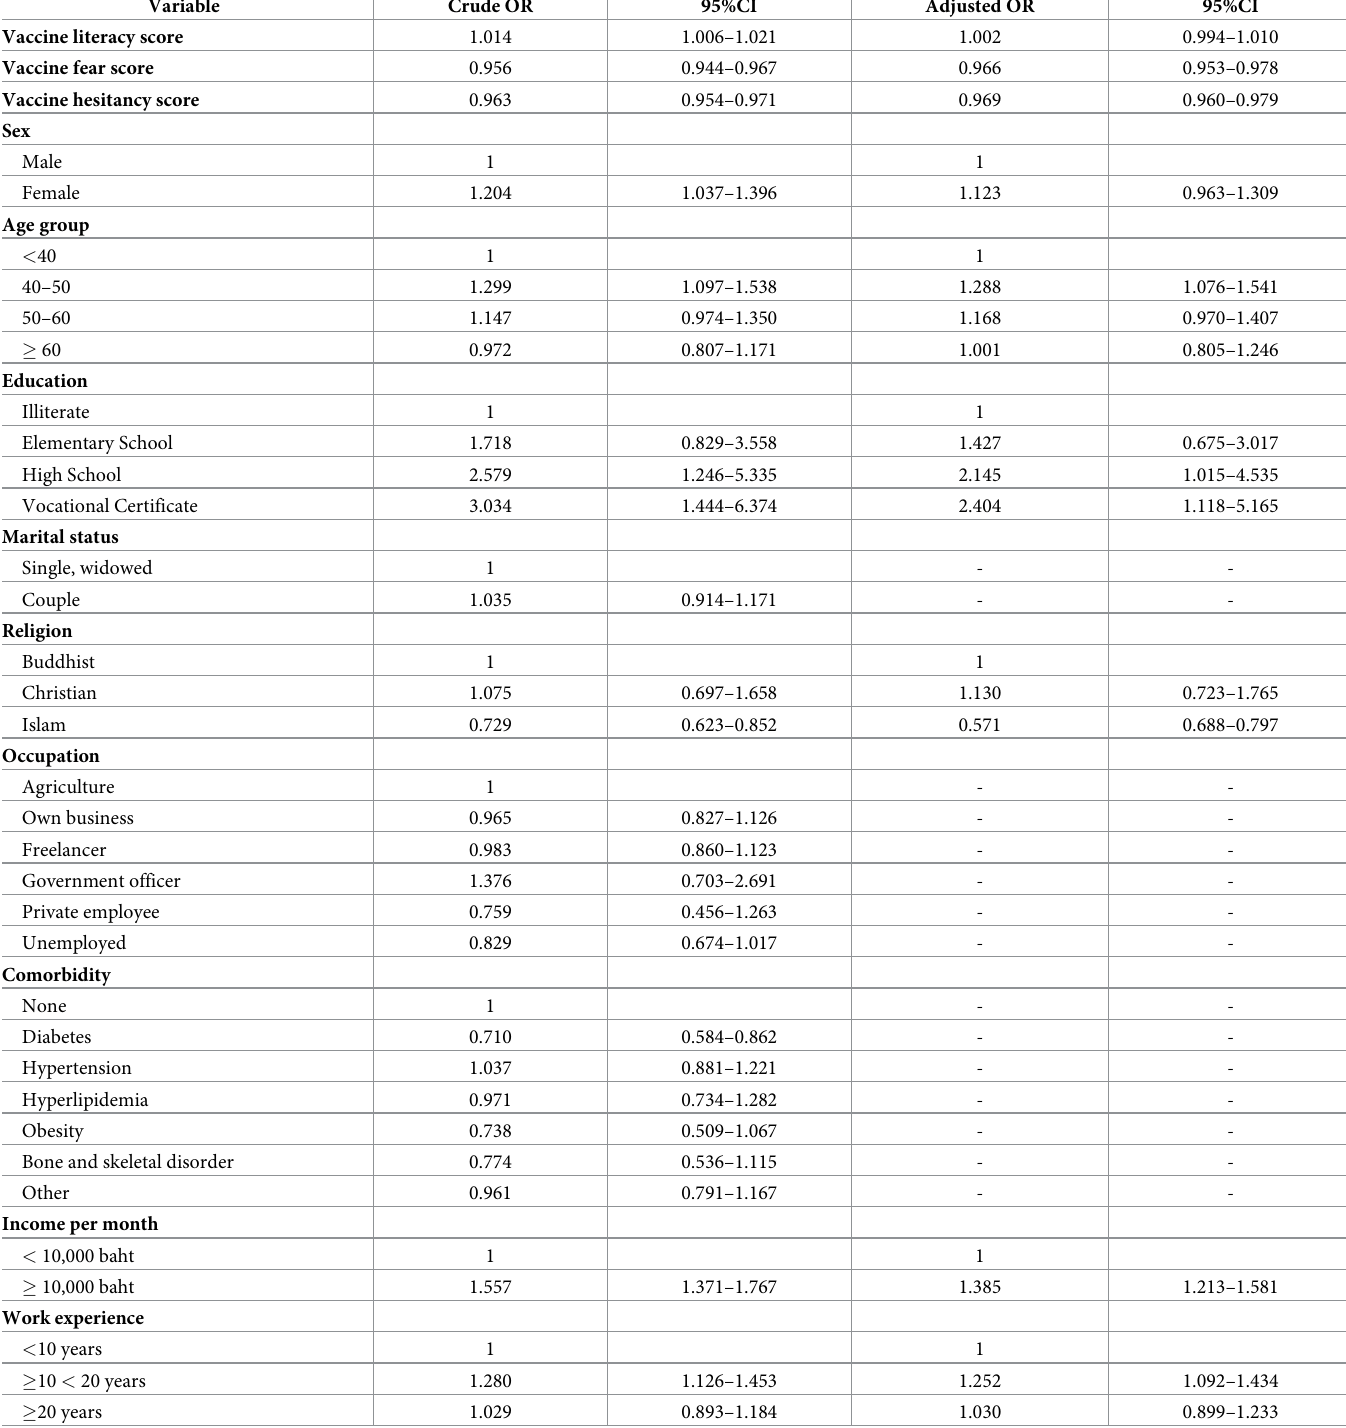
Table 2. Effect of literacy, fear and hesitancy scores on acceptance of COVID-19